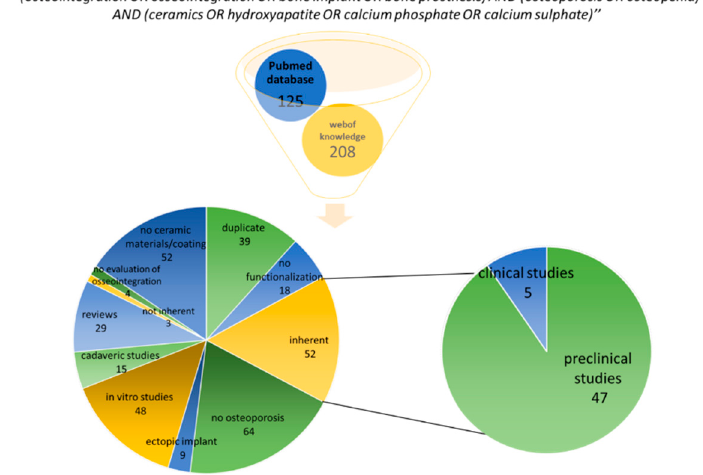
Figure 1. Flowchart of the research strategy.